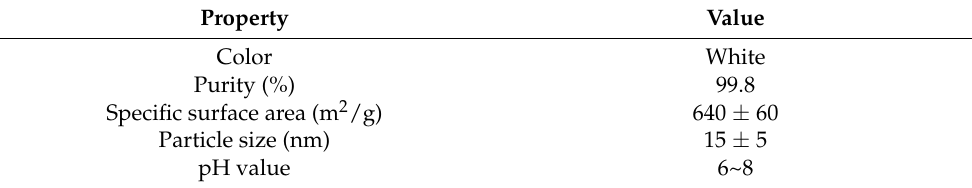
Table 3. Properties of nano-silica.